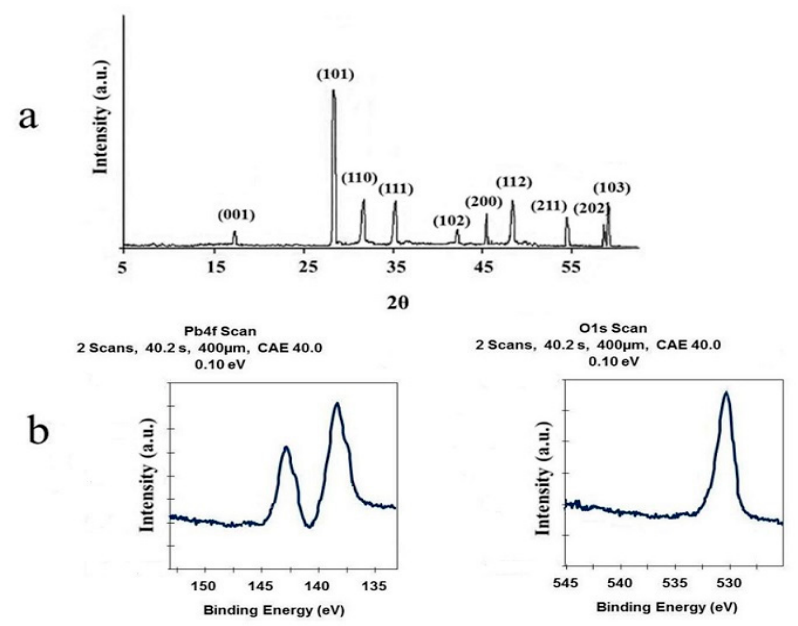
Figure 6. ( a ) XRD pattern and ( b ) XPS spectra of PbO nanoparticles prepared by thermolysis of compound 1 .